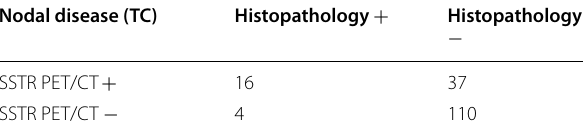
cut‑off value of max